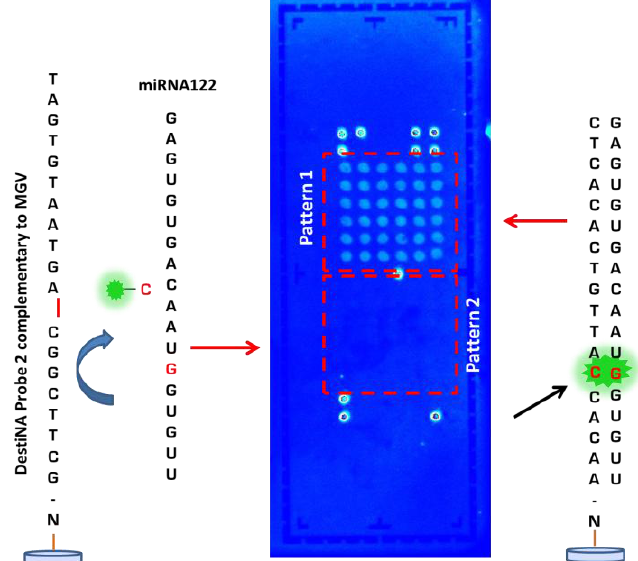
Figure 7. LoC scanned after DestiNA reaction with FITC-C shows where the oligo miRNA122 plus complementary DestiNA probe 1 attached to the array has correctly hybridised and fluorescence due to FITC-C by black arrow). On the other hand, red square (pattern 2) does not show fluorescence due to an absence of hybridisation between oligo miRNA122 plus DestiNA probe 2 (FITC-C incorporation not take CHO